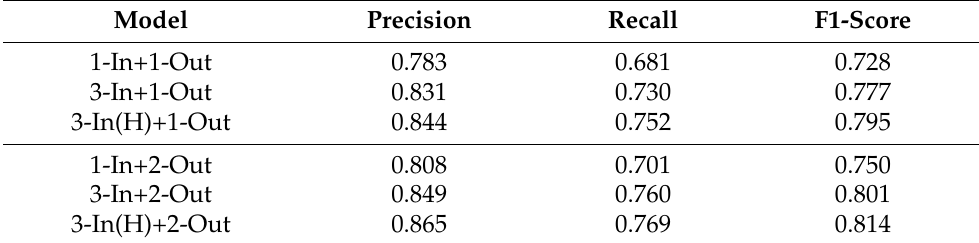
Table 5. Performance comparison depending on changes in the